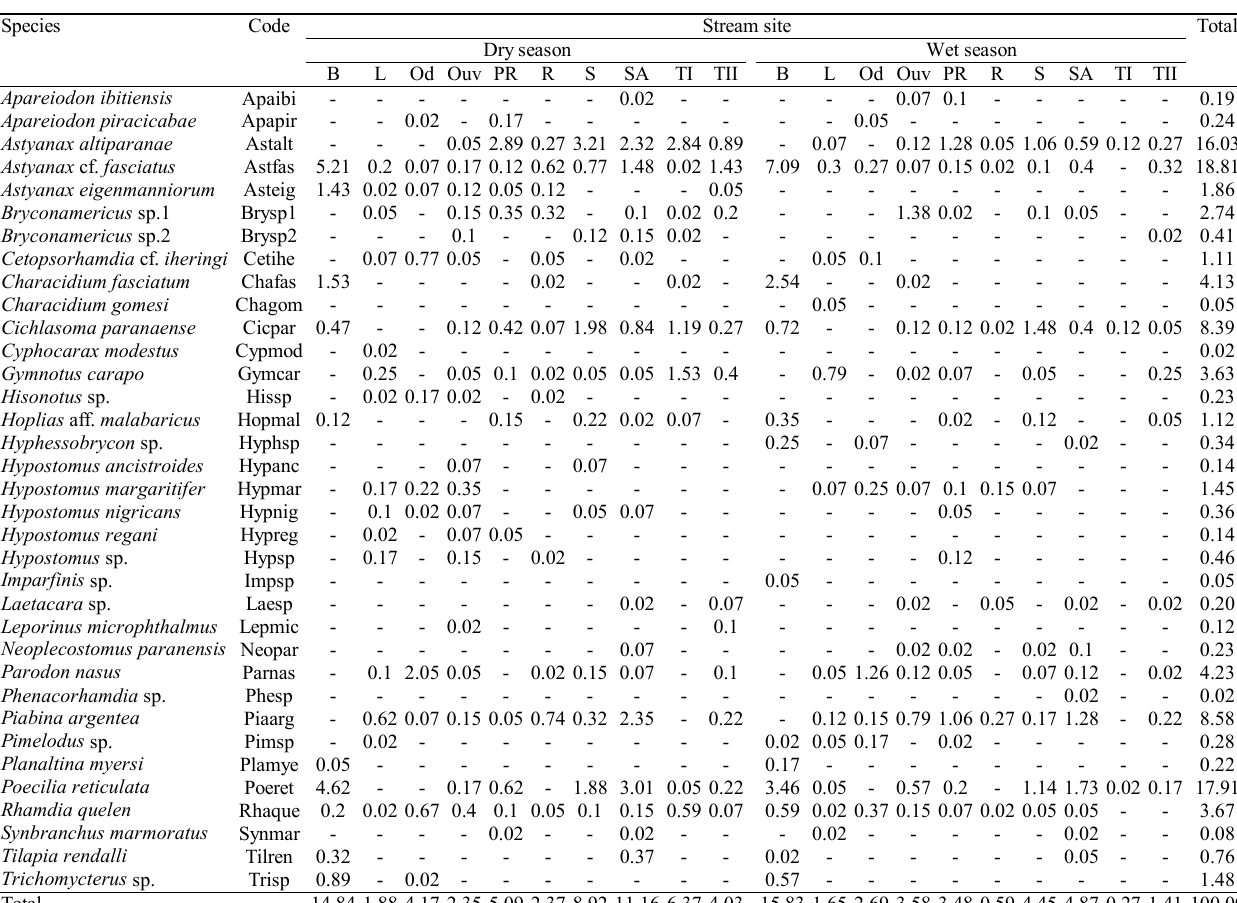
Table 3. Relative abundance of fish species by site. B = Buraco; L = Lagoa; Od = Olhos d’água; Ouv = Ouvidor; PR = Posse dos Rodrigues; R = Riacho; S = Sapê; SA = Santo Antônio; TI = Taquara I; TII =